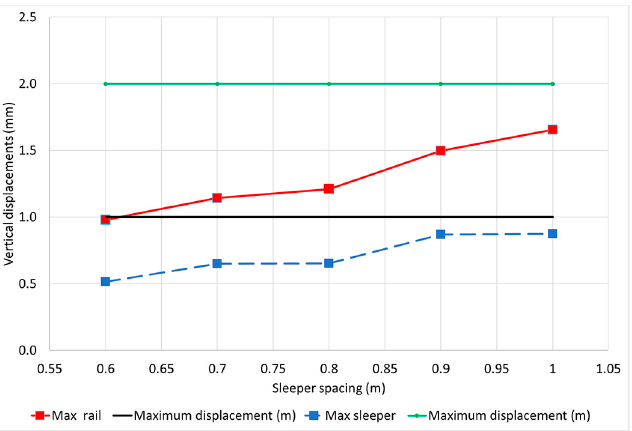
Figure 10. Maximum allowed limits for vertical displacements on rails and sleepers according to Table 7 values.